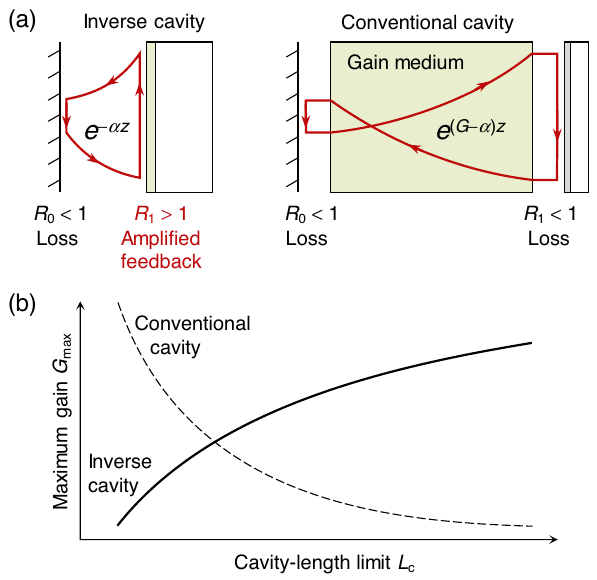
Figure 1. Inverse-cavity concept in comparison with the conventional cavity configuration. ( a ) Structure configuration of an inverse cavity versus a conventional cavity. Arrowed loops indicate instantaneous optical intensity during one roundtrip at lasing threshold. ( b ) Relation between minimal cavity length limit L c and maximum gain constant G max for an inverse-cavity structure in comparison with a conventional cavity